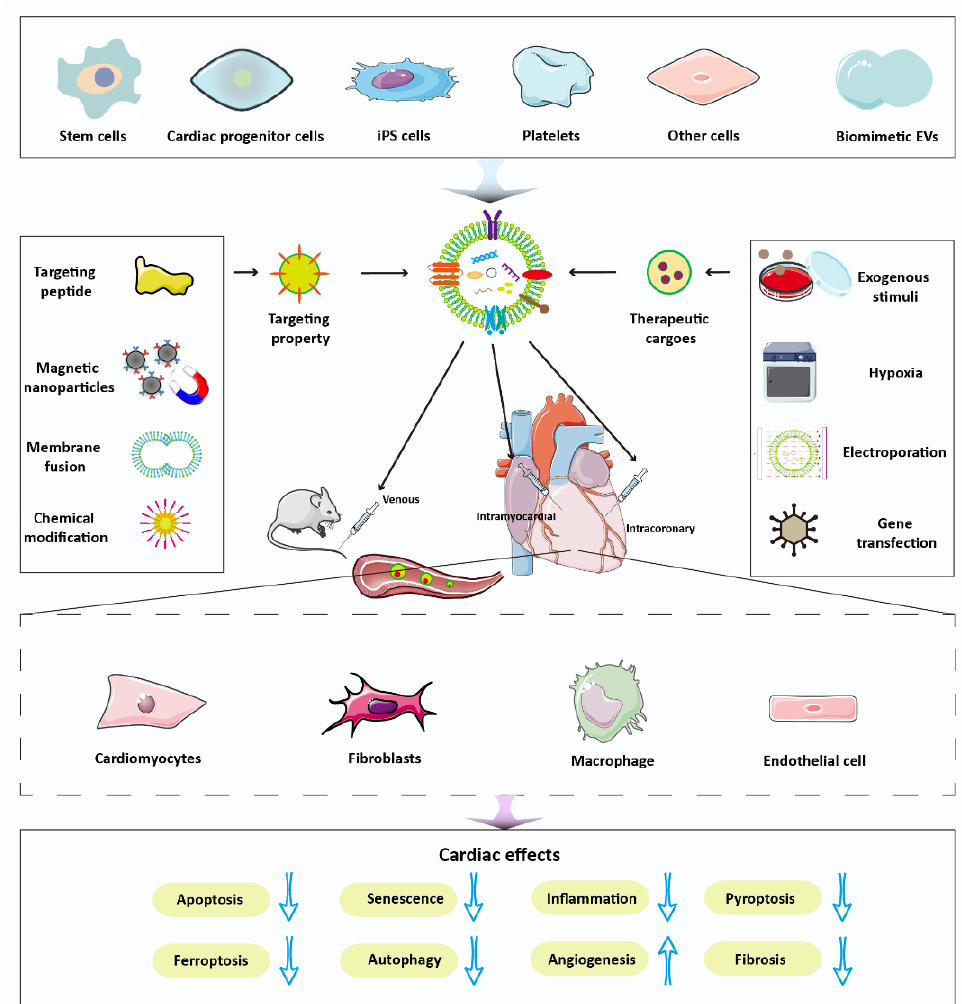
Figure 4. Examples of EVs-modulation strategies for cardiac therapies. Different sources derived-EVs can be modified to increase the therapeutic cargoes and targeting ability for cardiac repair through various injection ways. Then, EVs are able to regulate multiple effect cells including cardiomyocyte, fibroblast, macrophage, and endothelial cells for cardioprotective effects through multiple pathways.